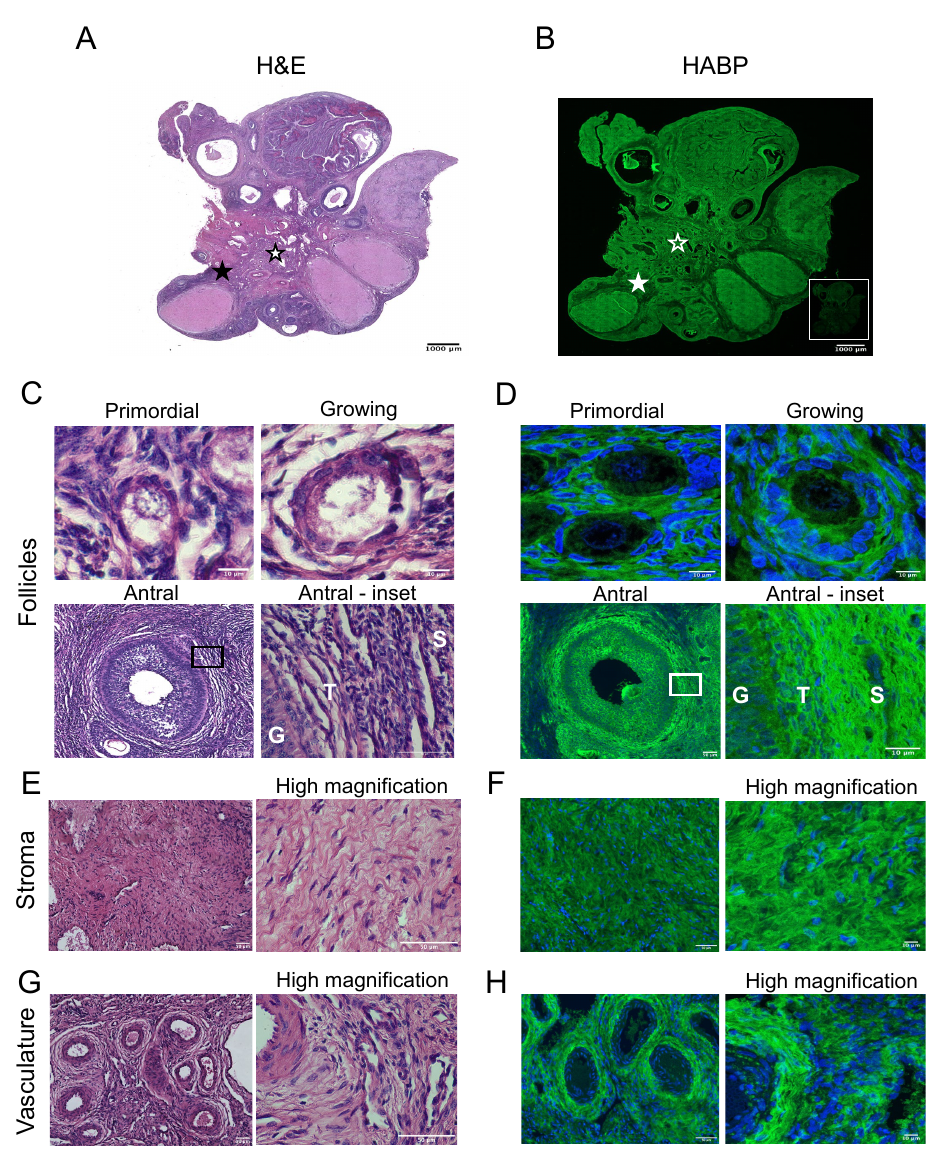
Figure 5. Porcine ovaries are hyaluronan rich. H&E staining ( left ) and HA localization ( right ) in porcine ovarian tissue sections. ( A ) H&E staining showing the microanatomical structures in the porcine ovary. ( B ) HABP staining localizing HA (green) in the porcine ovary. The inset illus- trates HABP staining after pretreating a serial ovarian tissue section with hyaluronidase. H&E and HABP staining in ( C , D ) primordial follicle, growing follicle, and antral follicle, ( E , F ) stroma, ( G , H ) vasculature, respectively. The area demarcated by the black rectangles in low magnifica- tion images ( C , D —Antral follicle) is shown in higher magnification images to the right. High magnification images of stroma ( E , F ) and vasculature ( G , H ) are seen to the right of each low mag- nification image. For H&E images, black stars indicate location of the stroma, and white stars indicate the location of vasculature ( A ). For HABP images solid white stars represents stroma location and white star outline represent the vasculature ( B ). G—granulosa cell layer, T—theca cell layer, S—stroma. The scale bars are ( A , B ) 1000 µ m and in ( C , D ) primordial follicle 10 µ m, antral follicle(50 µ m, antral-inset 10 µ m. ( E , G ) 50 µ m, ( F , H ) HABP staining 50 µ m, high mag- nification 10 µ m. Images are representative of porcine ovaries ( n = 2 pigs, n = 2 ovaries/pig, n = 2